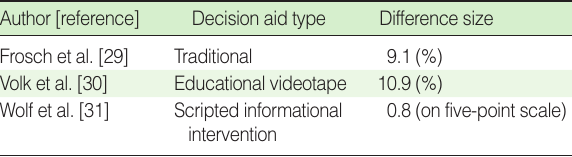
Table 3. Effect sizes of decision aids for prostate cancer